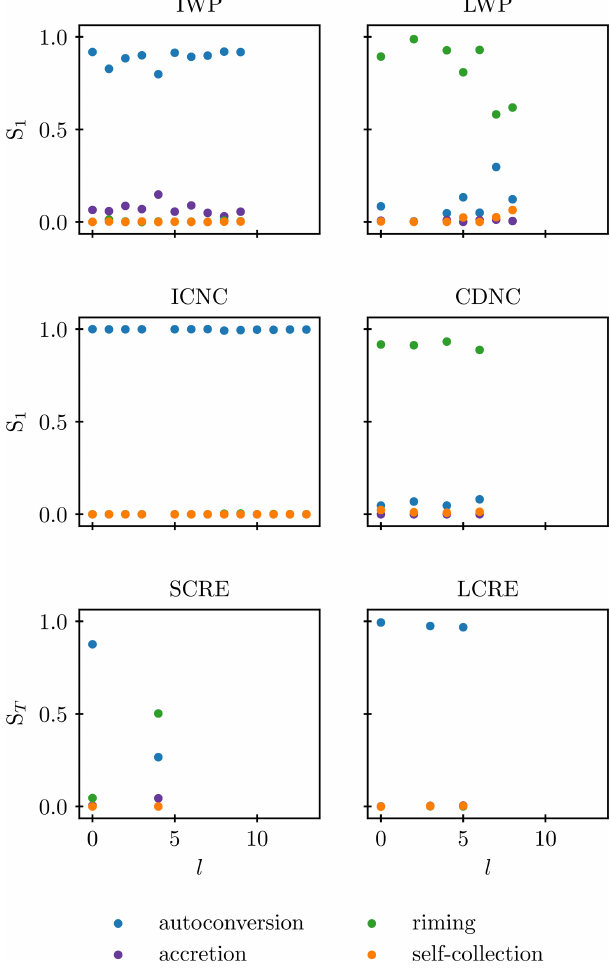
Figure 11. First-order sensitivity indices for the emulated angular amplitude spectrum as a function of the spherical harmonics de- gree l for the variables as described for Fig. 9. As detailed in the text, emulators that were found to be defaulting in the validation procedure were not subjected to the sensitivity analysis so that the results for those l are missing here. The results for the total sensi- tivity index are shown in Fig. C1 in Appendix